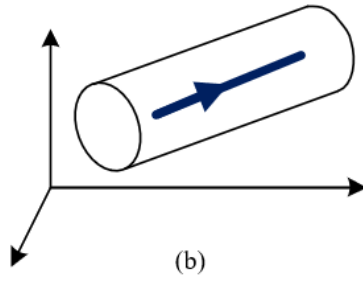
Figure 5. Sector for “vertical motion”, changing the flight altitude .